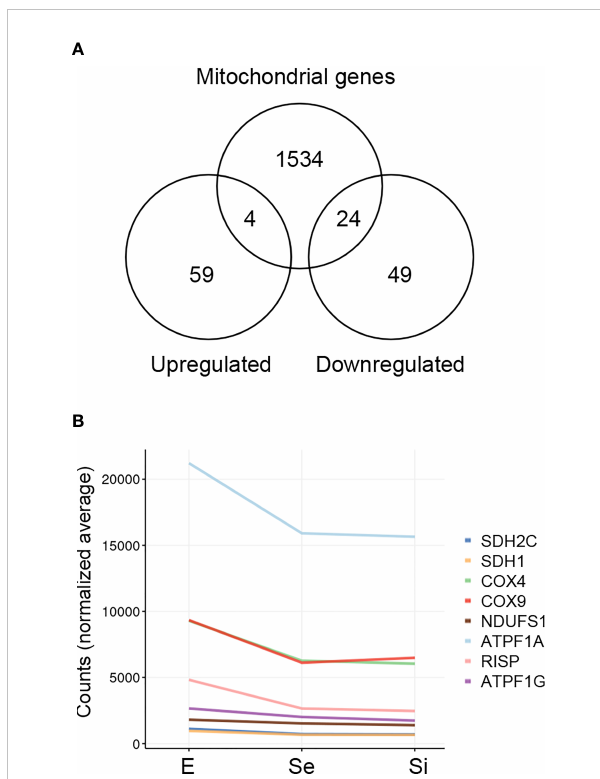
FIGURE 4 Mitochondrion-related DEGs of T. cruzi epimastigotes during prolonged cultures. The identi fi ed DEGs of early and intermediate stationary phase (Se and Si, respectively) in comparison to exponentially growing epimastigotes (E) were analyzed. (A) Venn diagrams comparing the Se ⋂ Si vs E DEGs with the genes with mitochondria term in TriTrypDB. (B) Spaghetti plot of nuclear genes encoding predicted mitochondrial proteins whose expression changes in starving conditions were previously reported (Shaw et al.,